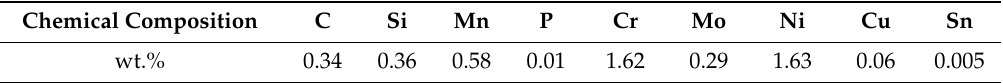
Table 2 lists the key parameters of the sample from the base material used according to the tensile Table 2. Tensile test performed at 23 ◦ C. diagram made after the standardized tensile test, namely yield strength, contraction, ductility as quantified plastic deformability before reaching the yield strength, and material yield strength. Table 2. Tensile test performed at 23 °C.